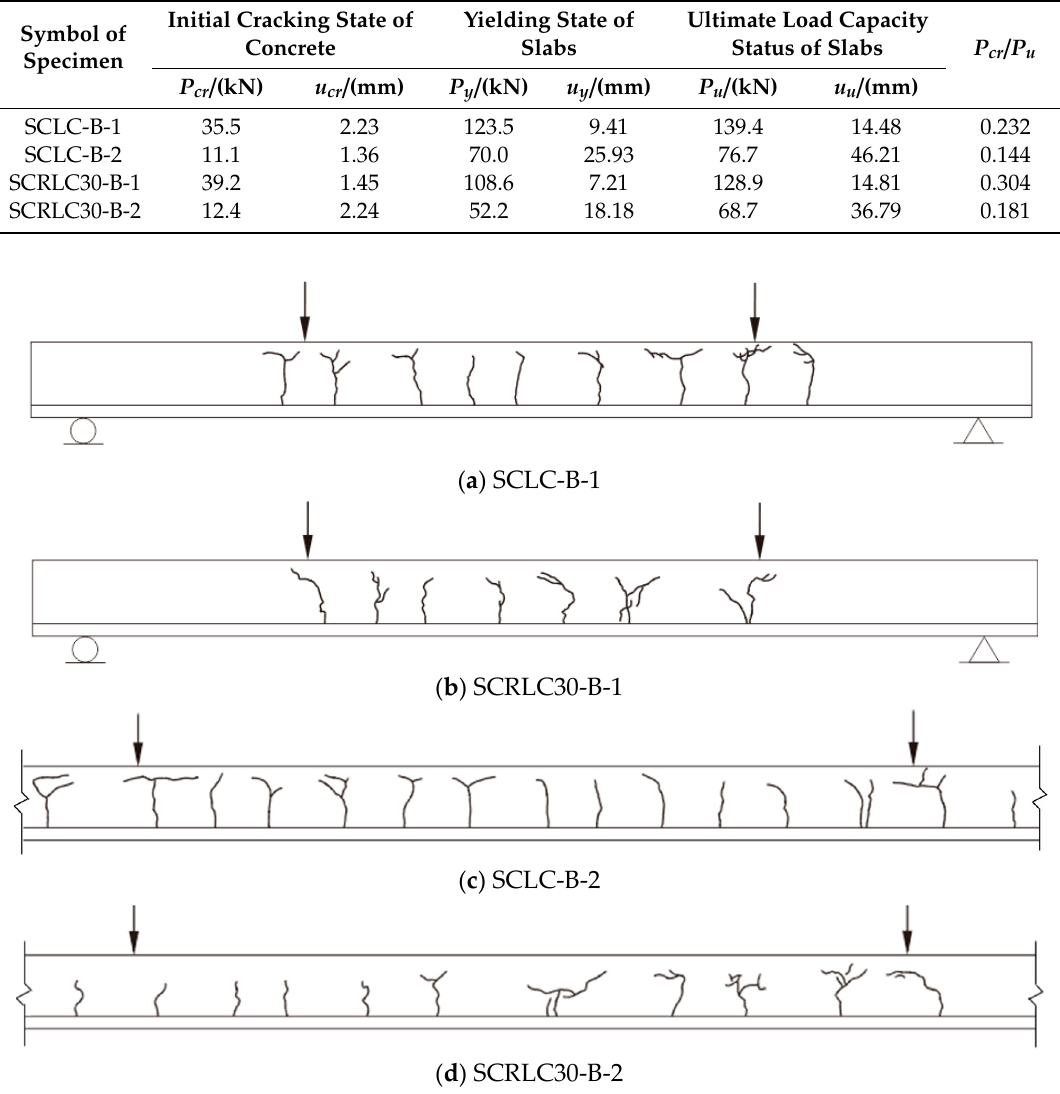
Figure 9. Final cracking patterns for each slab. ( a ) SCLC-B-1, ( b ) SCRLC30-B-1, ( c ) SCLC-B-2, ( d ) SCRLC30-B-2.